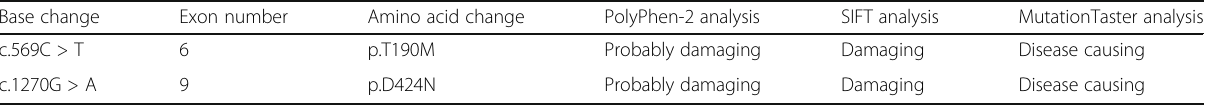
Table 1 Functional evaluation of the GLRA1 mutations detected in the family of a Chinese boy with hyperekplexia Base change Exon number Amino acid